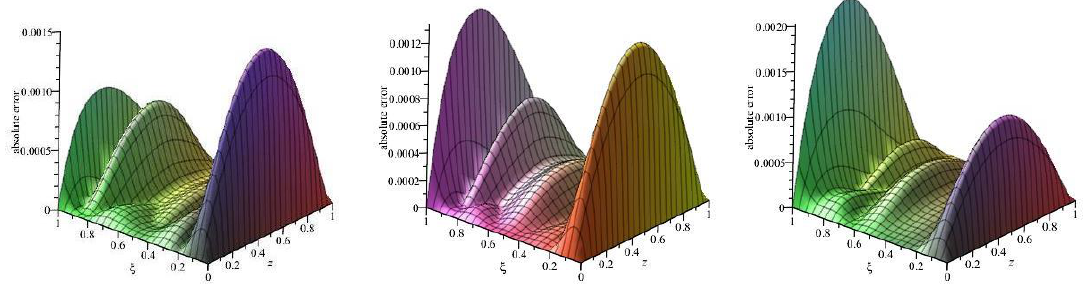
Figure 1. The surfaces show the absolute error of Example 1 with n = 16 ( a = b = 4 ) and for α = 0.7, α = 0.8, α = 0.9 respectively on region Θ